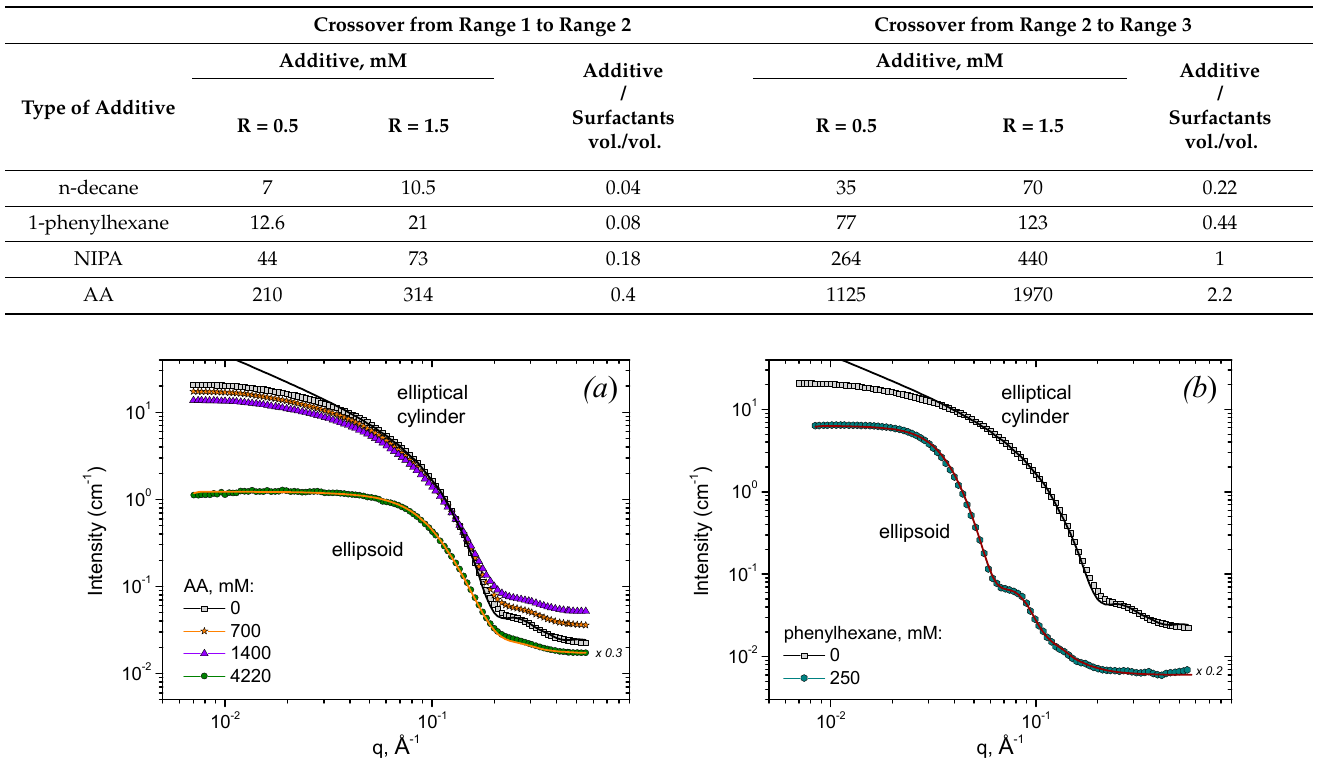
Table 1. Approximate additive concentrations (mM) corresponding to different ranges of viscosity drop in Figure 2b.